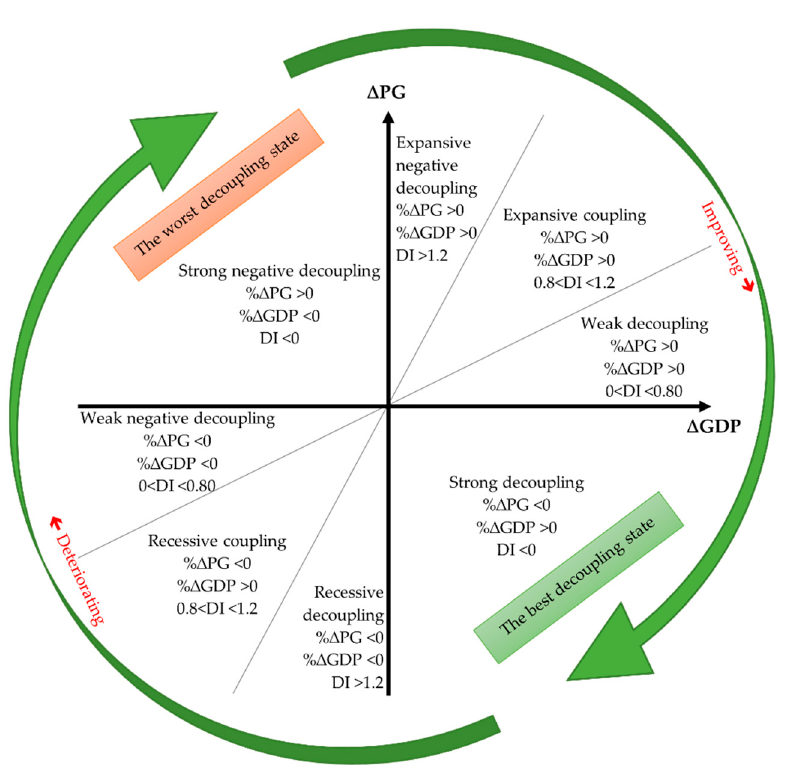
Figure 1. The schematic diagram of decoupling states. According to Tapio [42], in order to avoid overinterpreting slight changes as signifi- cant, elasticity values close to one continue to be considered as a coupling state. In Table 2, elasticity values between 0.8 and 1.2 are defined as a coupling state. This means that the change rate of GHG emissions is approximately equal to economic growth. For the other elasticity values, it is defined as a state of decoupling or negative decoupling. For a value of DI < 0, strong decoupling or strong negative decoupling can occur. The